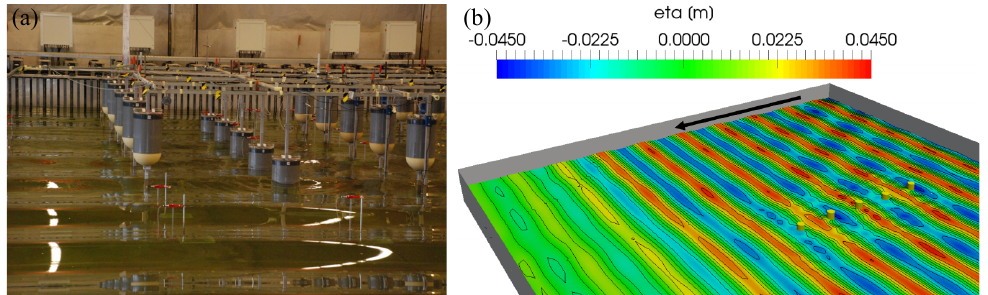
Figure 21. Point absorber arrays with physical and numerical models in ( a , b ), respectively, adapted from